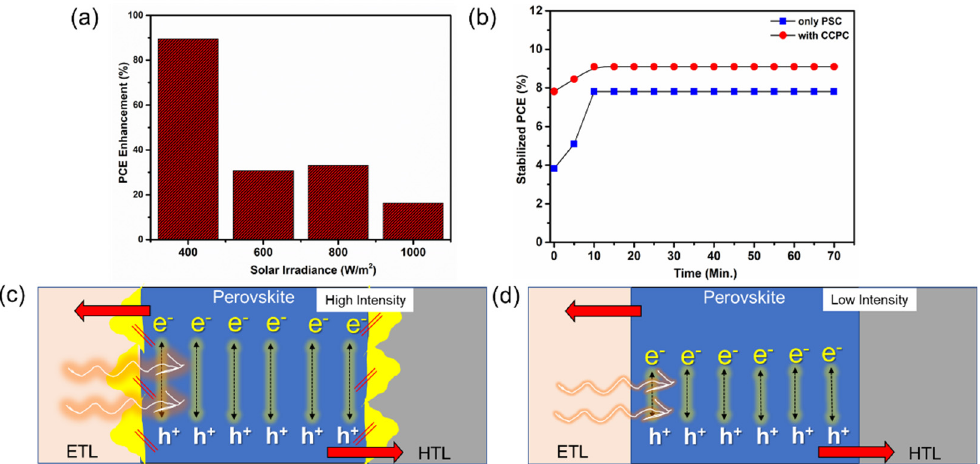
Figure 8. The ( a ) plot of power conversion efficiency (PCE) enhancement for different solar irradiance, ( b ) PCE stabilization kinetics plot for CCPC-integrated-PSC compared with PSC, and the schematic representation of photo-generated charge carries for ( c ) high-intensity and ( d ) low-intensity concentrated light, respectively, where the yellow markings indicate degradation of the perovskite, the arrow’s intensity indicates high and low incidence irradiance, and the red arrows represent the charge-carrier migration direction.